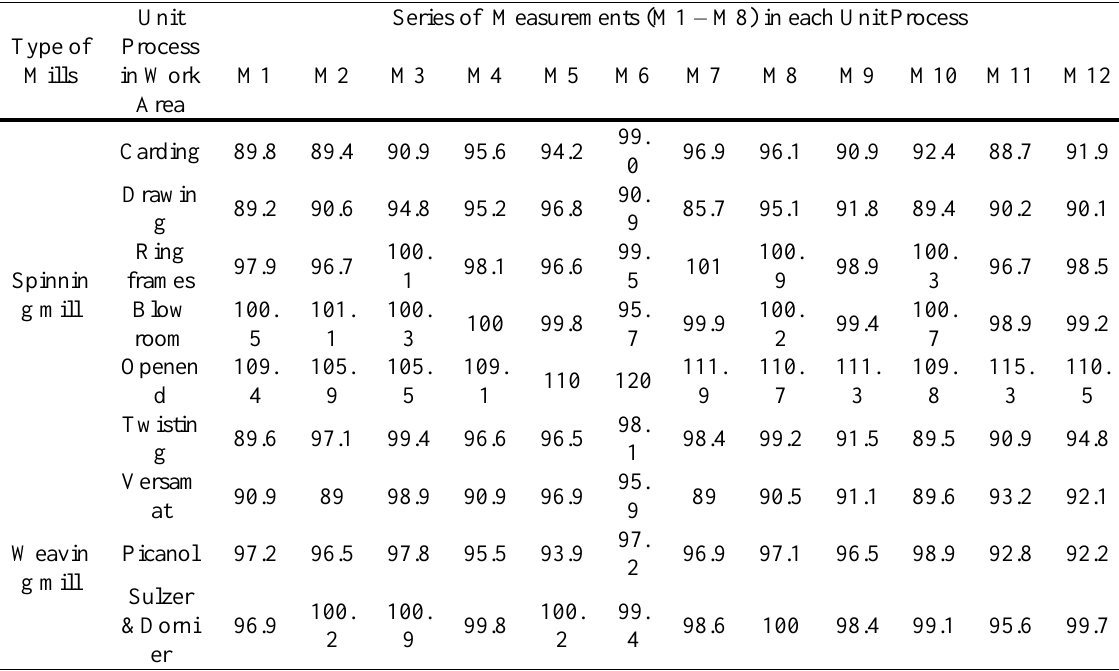
Table 1. The overall noise level measurement result in dBA recorded from each unit processes.